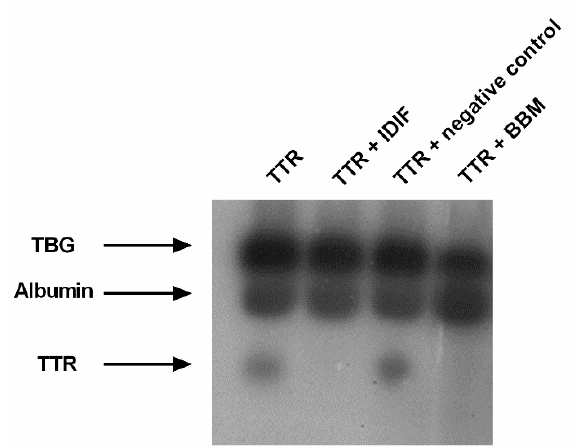
Figure 3. T4 displacement from TTR. Native gel electrophoresis of human plasma, incubated with 125 I-T4 and competitor, showing that IDIF and BBM can compete with T4 for its binding site, whereas the negative control could not displace T4 from TTR. The migration of the different plasma T4-binding proteins is indicated.